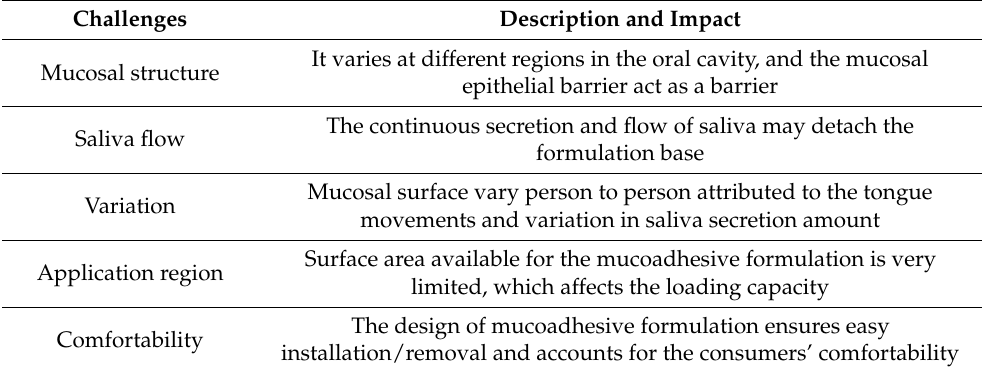
Table 2. Challenges associated with the mucoadhesive dosage formulation.